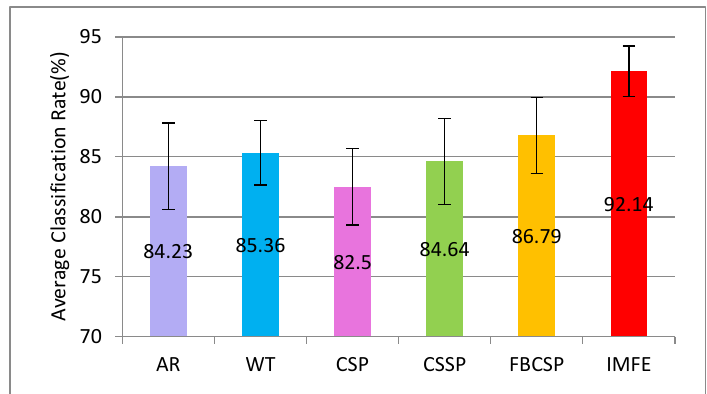
Figure 11. The average classification accuracy and standard deviation performed by 10-fold CV for IMFE and multiple classical feature extraction methods.